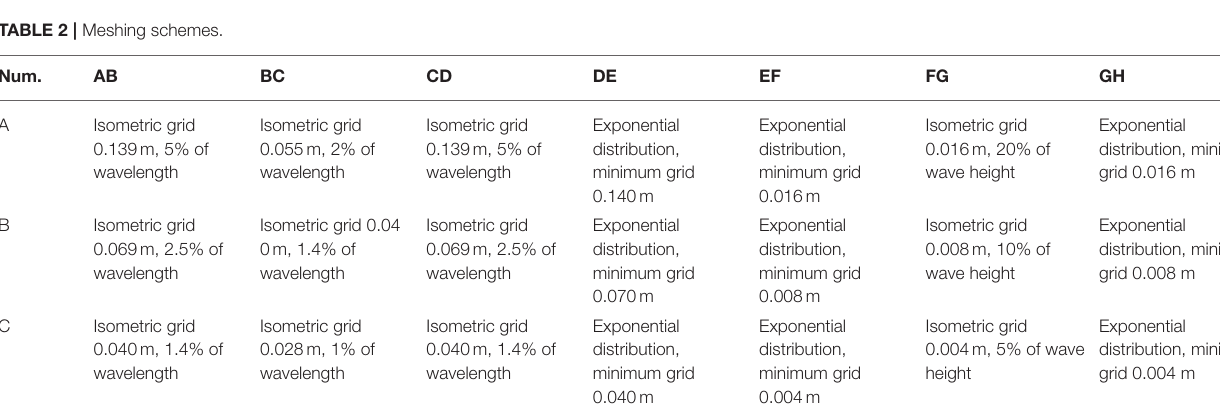
TABLE 2 | Meshing